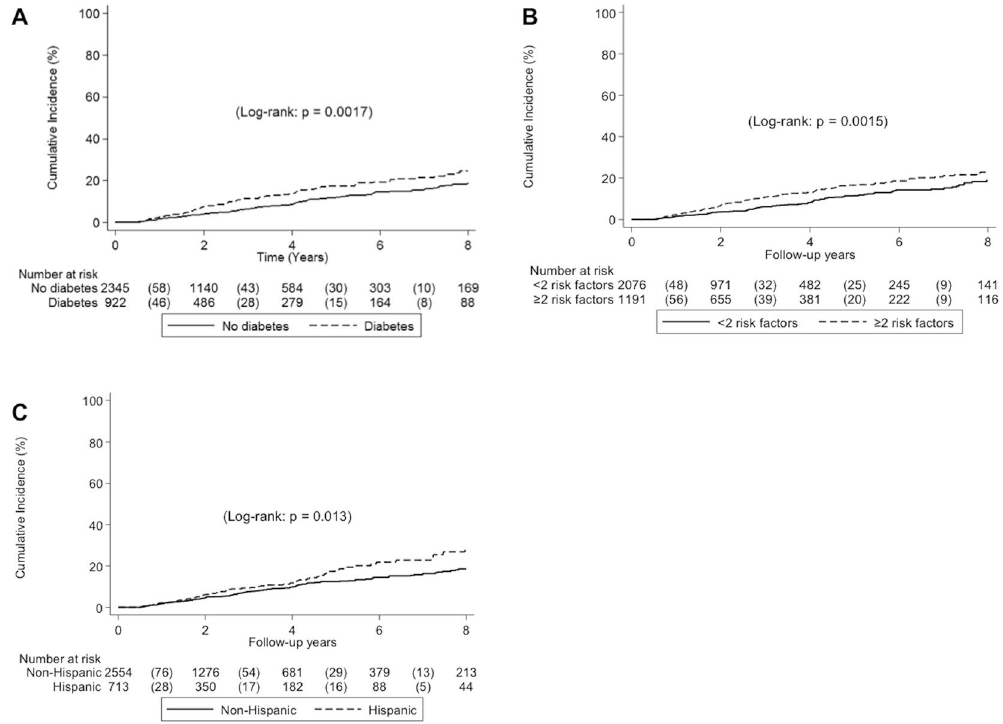
Figure 2. Incidence of hepatocellular carcinoma by ( A ) diabetes status ( B ) number of metabolic risk factors and ( C ) Hispanic ethnicity.